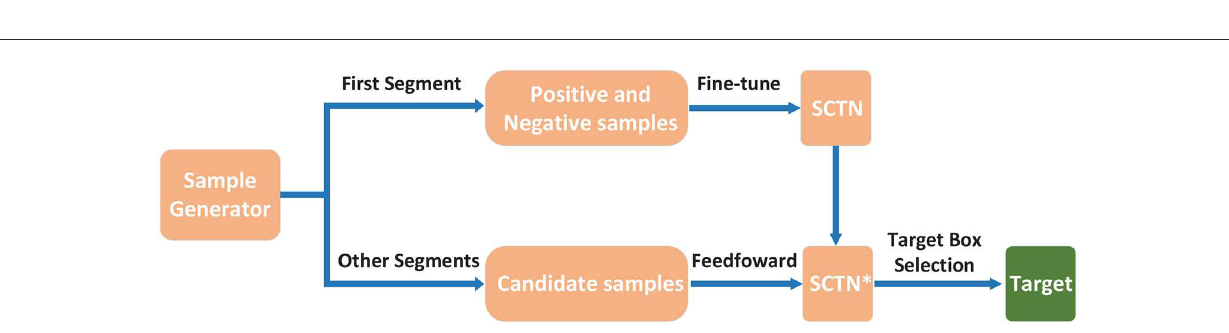
FIGURE3 Test flowchart of SCTN. In the test phase, positive and negative samples are generated by the sample generator in order to fine-tune SCTN using the first segment of the test sequence. For other segments, the candidate samples are also created by the sample generator, in which we need to choose an optimal candidate sample as the target bounding box through the evaluation of SCTN ∗